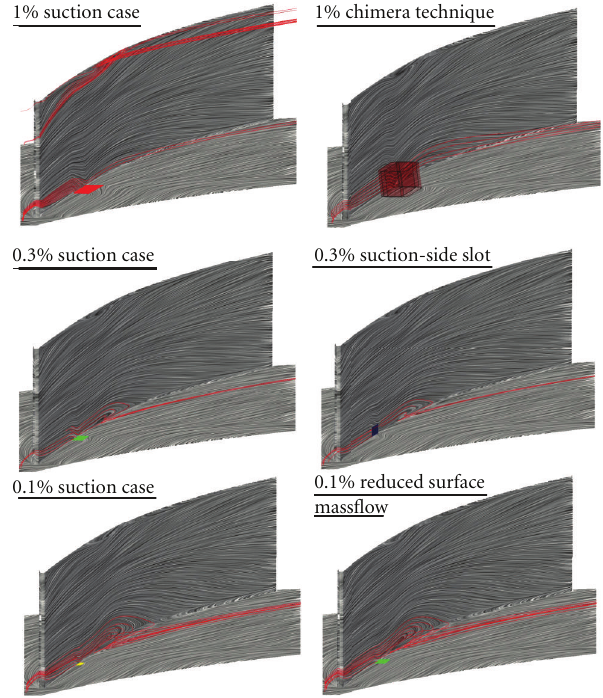
Figure 19: Skin-friction patterns for the di ff erent aspirated di ff